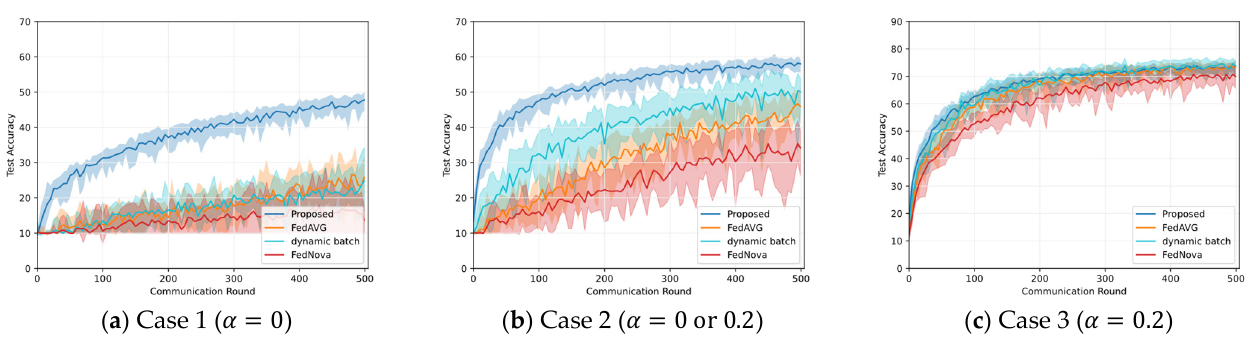
Figure 6. Accuracy comparison among the proposed algorithm, ‘dynamic batch’, and two baseline algorithms on different non-IID situations. algorithms on different non-IID